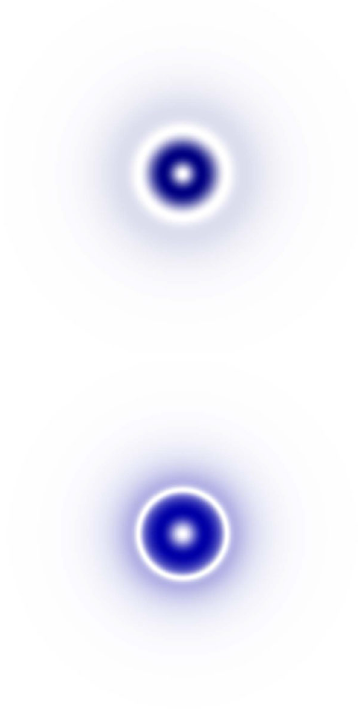
Fig. 4 The energy density in Eq. (45) in the plane for α = 2 (top) and 10(bottom).Theintensityofthebluecolorincreaseswiththeincreasing of the of the energy